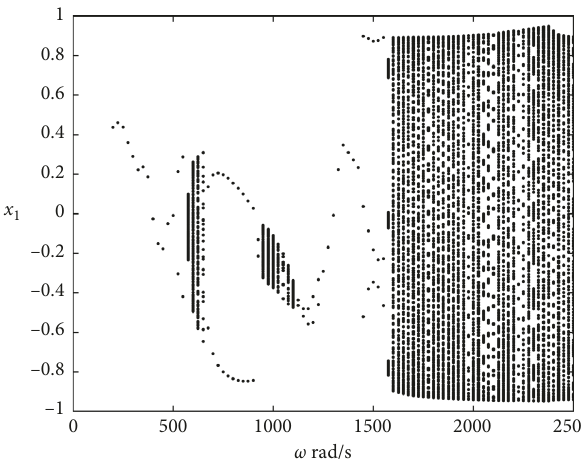
Figure 9: Bifurcation diagram of the rotor system in the x rection when b 1 �